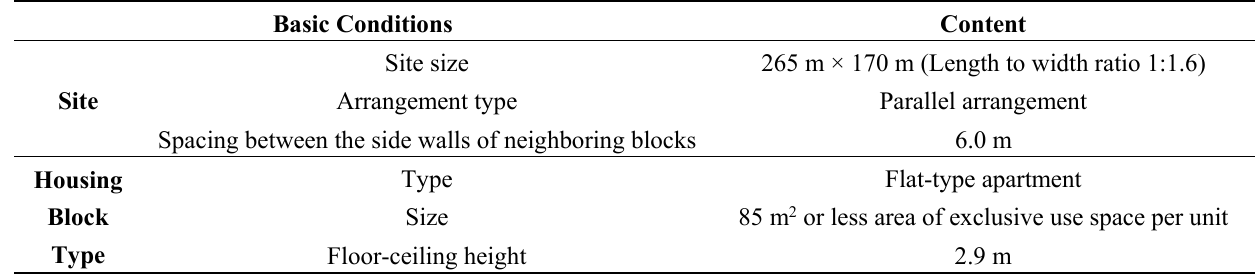
Table 1. Site arrangement condition and housing block type